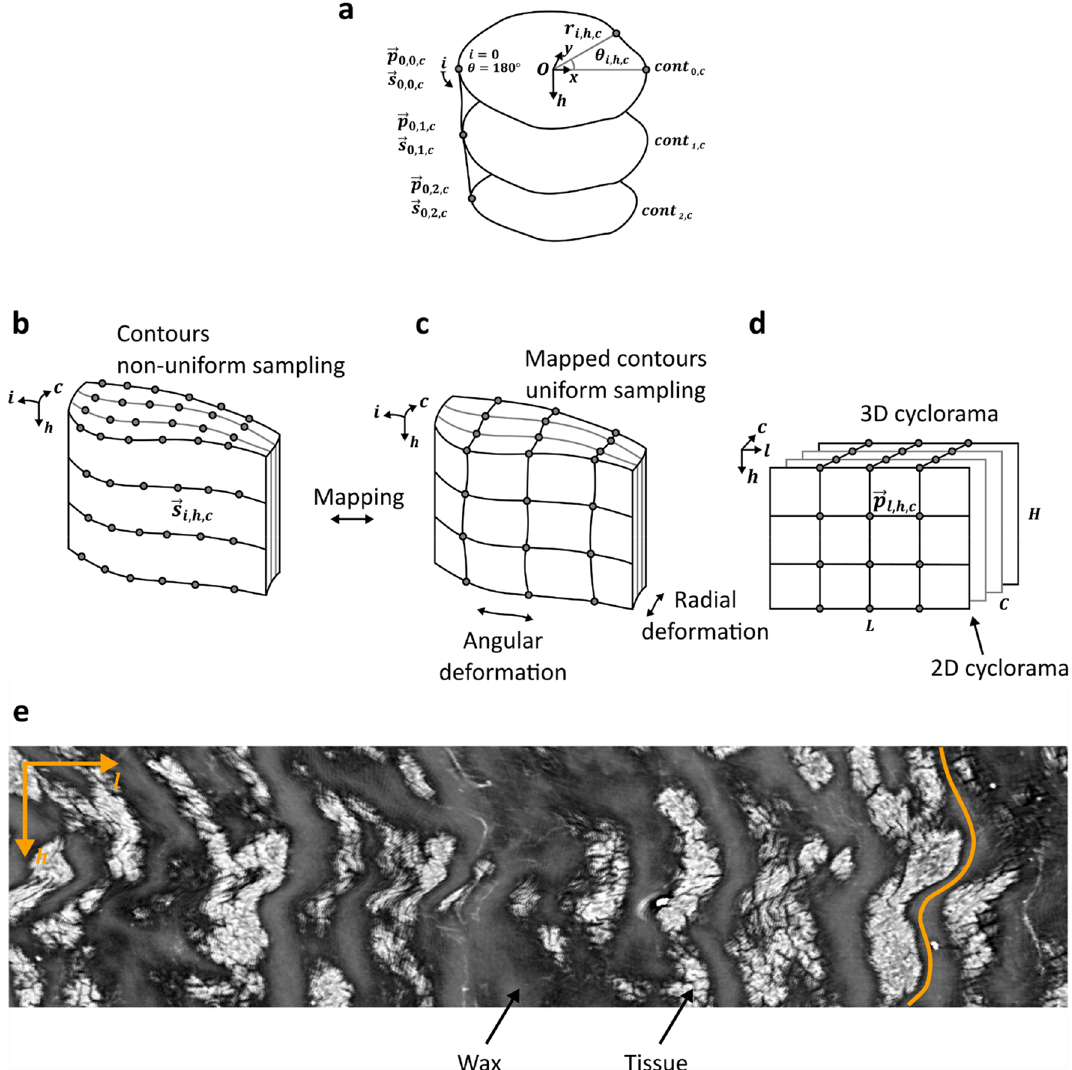
Figure 3. Linear mapping of 3D re-slicing surfaces. ( a ) The re-slicing surface edge at depth level c is defined by selecting the first point � s i , h , c = � s 0, h , c = (cid:31) r 0, h , c , 180 ◦ (cid:30) . ( b ) Initial re-slicing surfaces are represented as unstructured contours. ( c ) The points in the unstructured contours in b are mapped onto the structured grid in c . ( d ) The structured grid shown in c is used to probe the 3D image data and create the 3D cyclorama. ( e ) A section of a 2D cyclorama at 0% relative depth level ( c = 0 : inner boundary) of a healthy murine colon embedded in paraffin wax, which partially probes volumes from the background (paraffin wax) and the sample (tissue). Vertically curved patterns are visible, as revealed by the orange outline of the tissue. This is a consequence of local image deformations (stretching/contraction), which results in anisotropic pixel sizes. ( a-d ) Sketches a-d were created with Inkscape 14